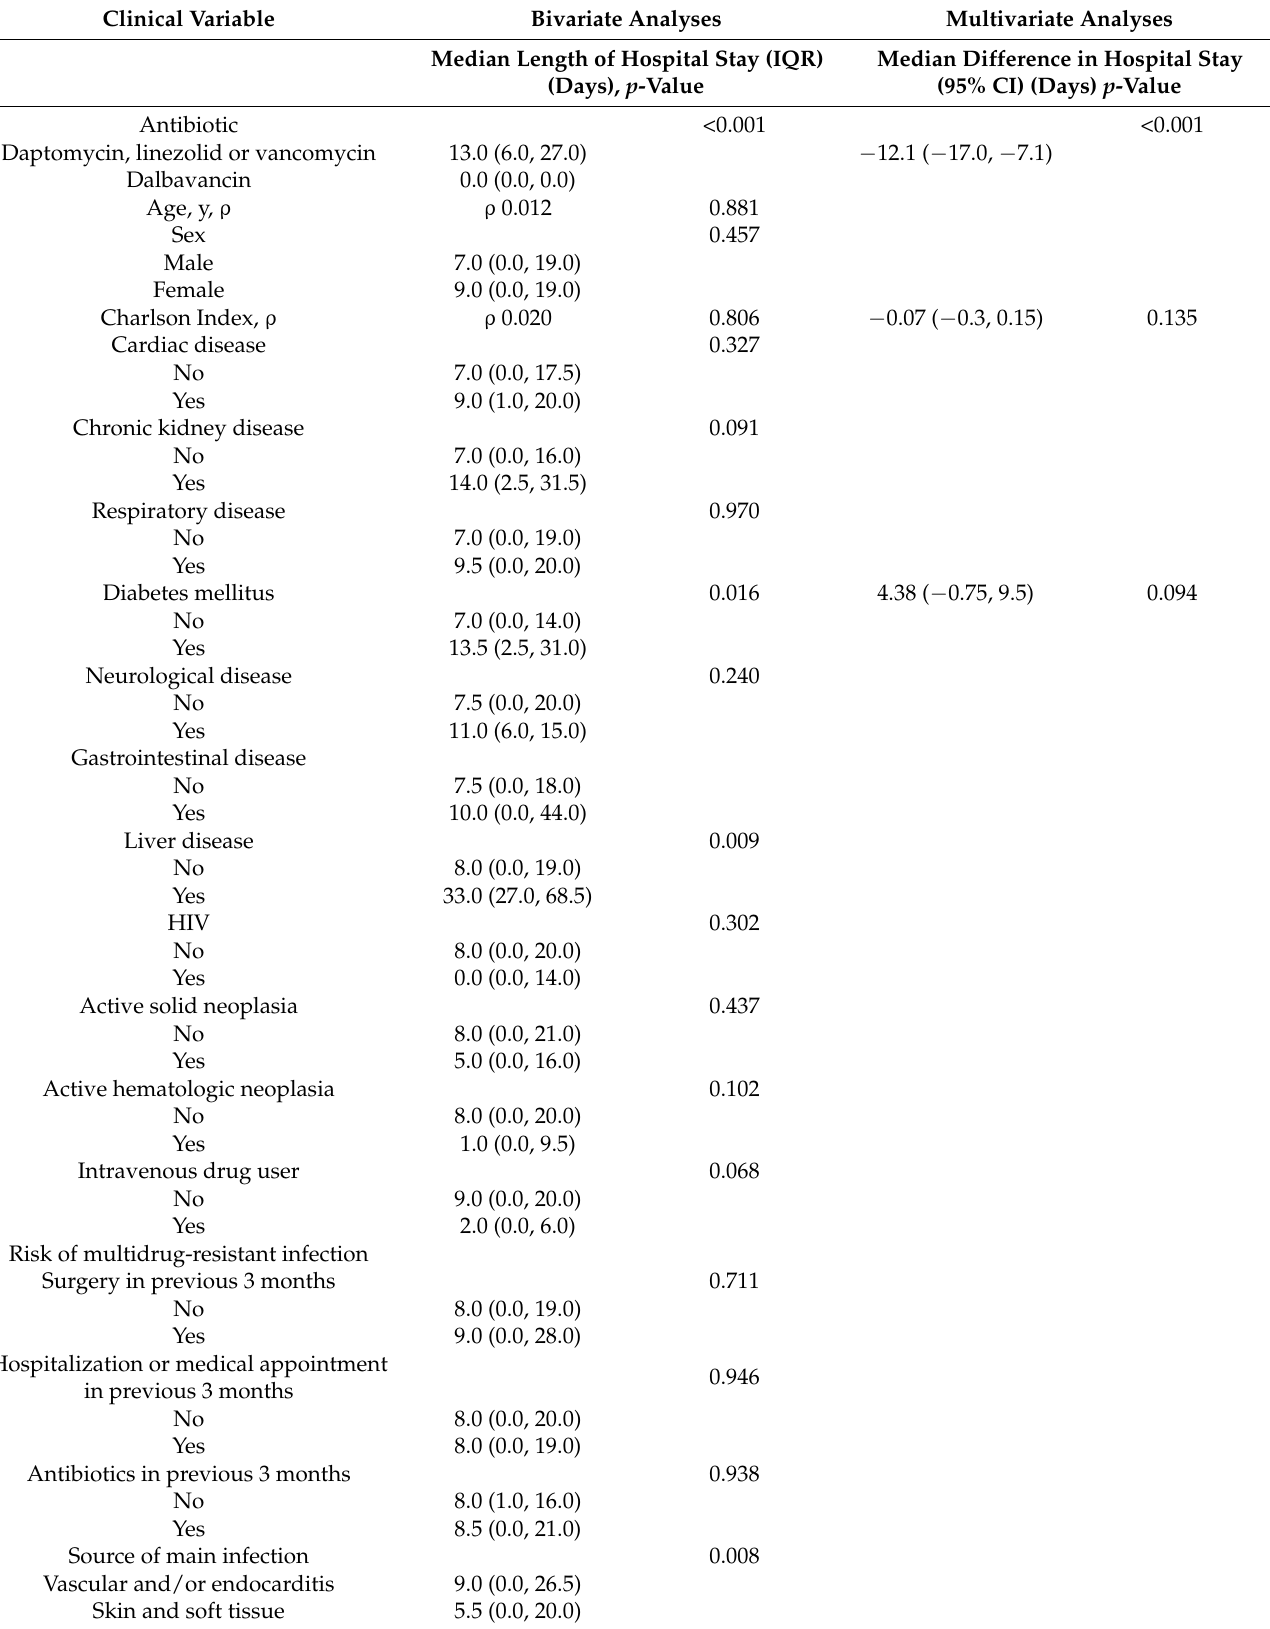
Table 3. Bivariate and multivariate analyses of factors related to the length of hospital stay. Clinical